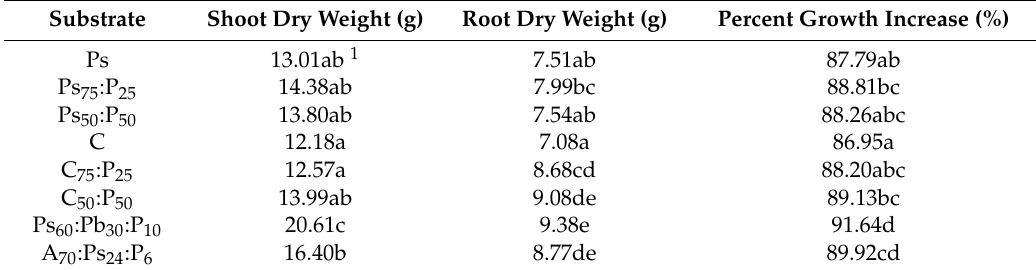
Table 6. Shoot and root dry weights at the end of the experiment and percent growth increase (%) of begonia plants throughout the duration of the experiment as affected by the substrate type.